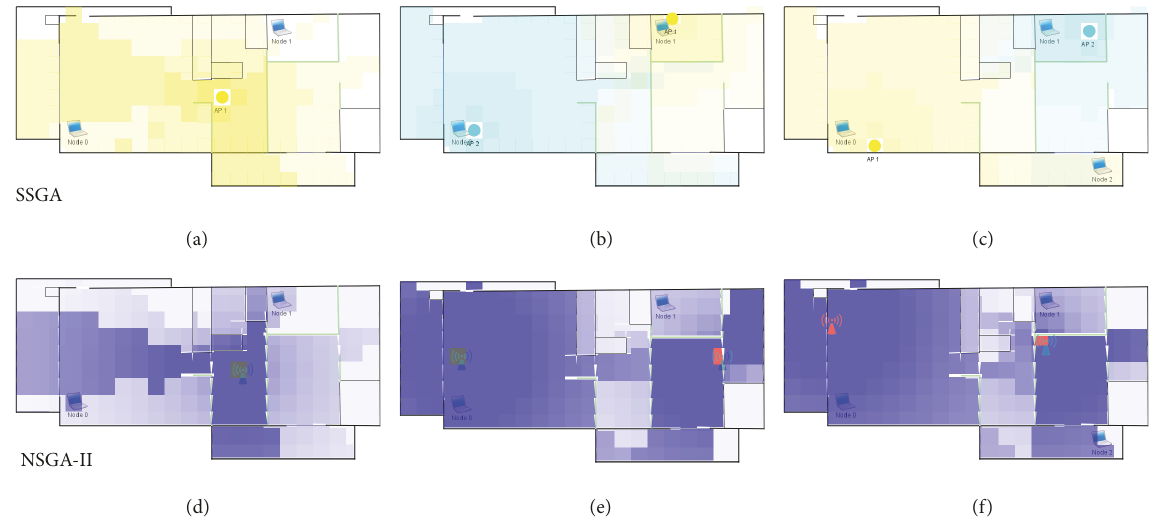
Figure 5: Comparison of solutions for SSGA and NSGA-II: (a)–(d) one AP covering one client, (b)–(e) two APs covering two clients, and (c)–(f) two APs covering three clients.